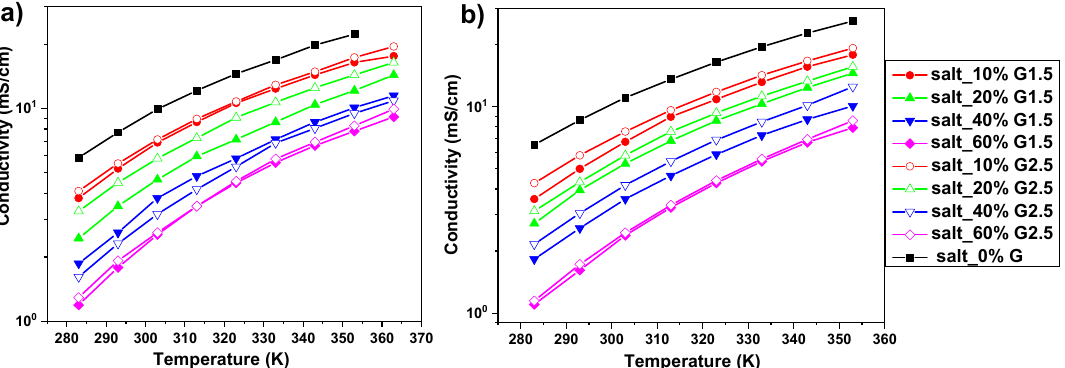
Figure 2. Temperature dependence of ionic conductivity for ( a ) LiTFSi salt and ( b ) NaTFSi salt-based electrolytes with 0, 10, 20, 40, and 60 wt% of PAMAM dendrimers with generations G1.5 and G2.5.